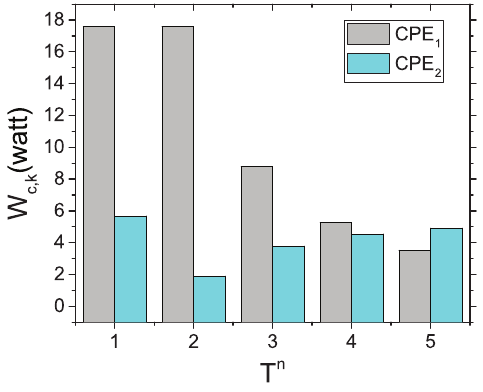
Figure 2. Effect of T n over the